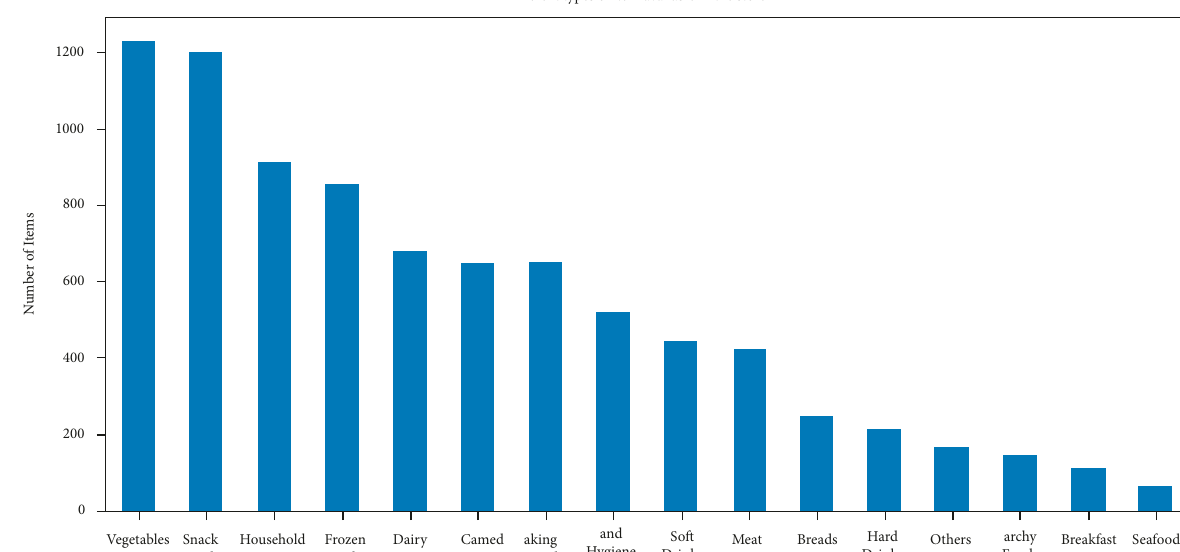
Figure 4: Different varieties of fats in items in the